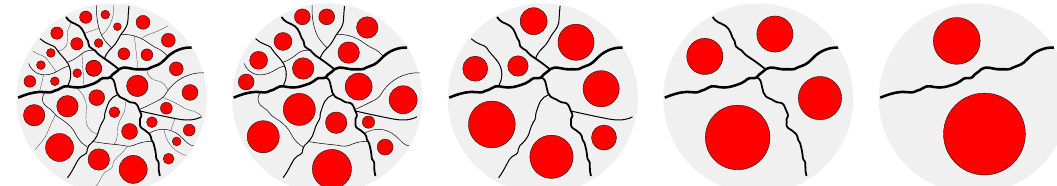
Figure 2: Cartoon “snapshots” of a contraction sequence based on a separator hier- archy. Circles designate vertices of a graph and black lines are separators; edges are not shown. Circle size is proportional to vertex degree and thicker lines are separa- tors higher in the hierarchy. Starting from the leftmost panel, edges of the shortest separators in the hierarchy are contracted, yielding the graph in the next